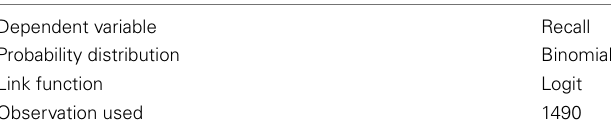
TableA2 | Basic repeated measure logistic regression model information.